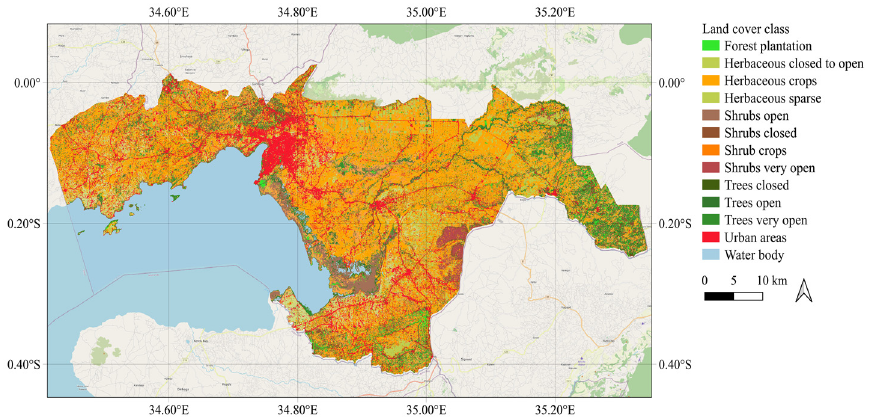
Figure 5. 2020 land-cover map of Kisumu prepared from the subsets of Africover legends of Kenya (2000).